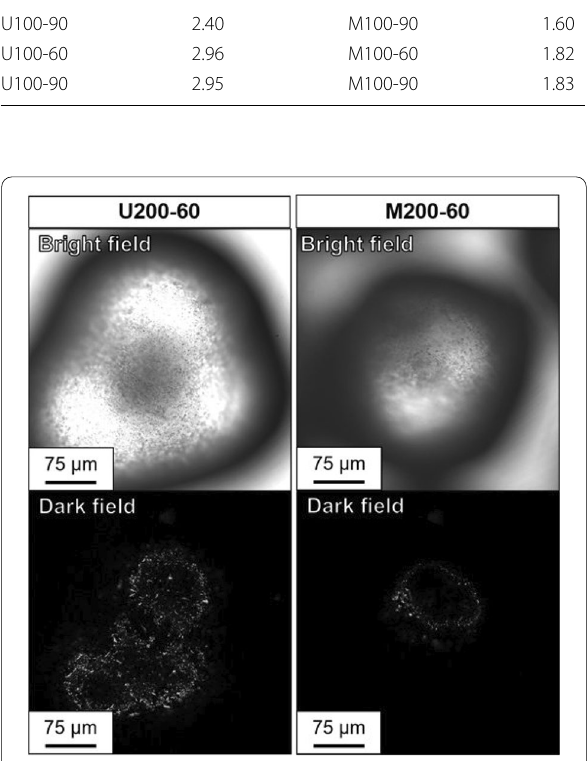
Fig. 8 CLSM images of iPP particles with adsorbed nanofibrils